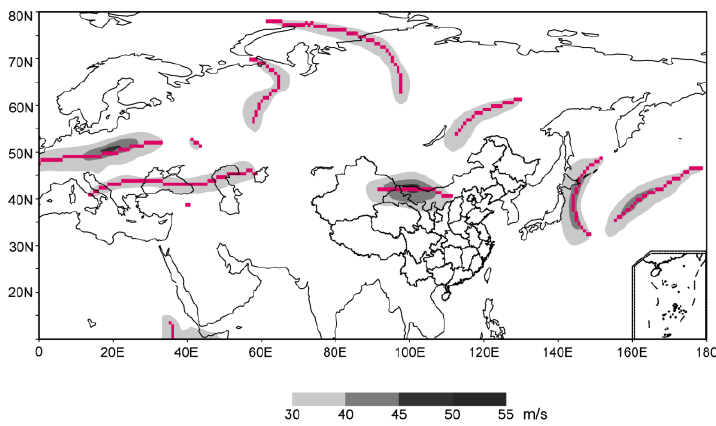
Figure 3. Upper level jets over 350 K isentropic surface (shadings, unit: m s − 1 ) at 0000 UTC 20 July 2012 with their corresponding axes (red solid lines).